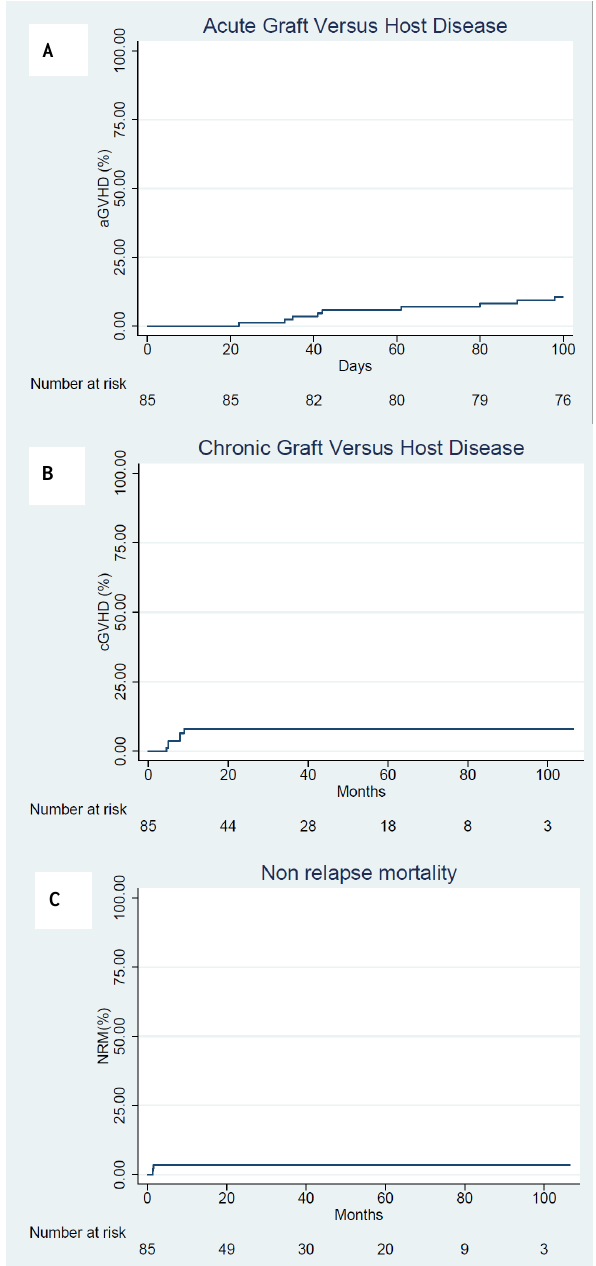
Figure 1. Transplant-related complications. ( A ) Cumulative incidence of acute graft-versus-host disease (aGVHD). ( B ) Cumulative incidence of chronic graft-versus-host disease (cGVHD). ( C ) Non-relapse